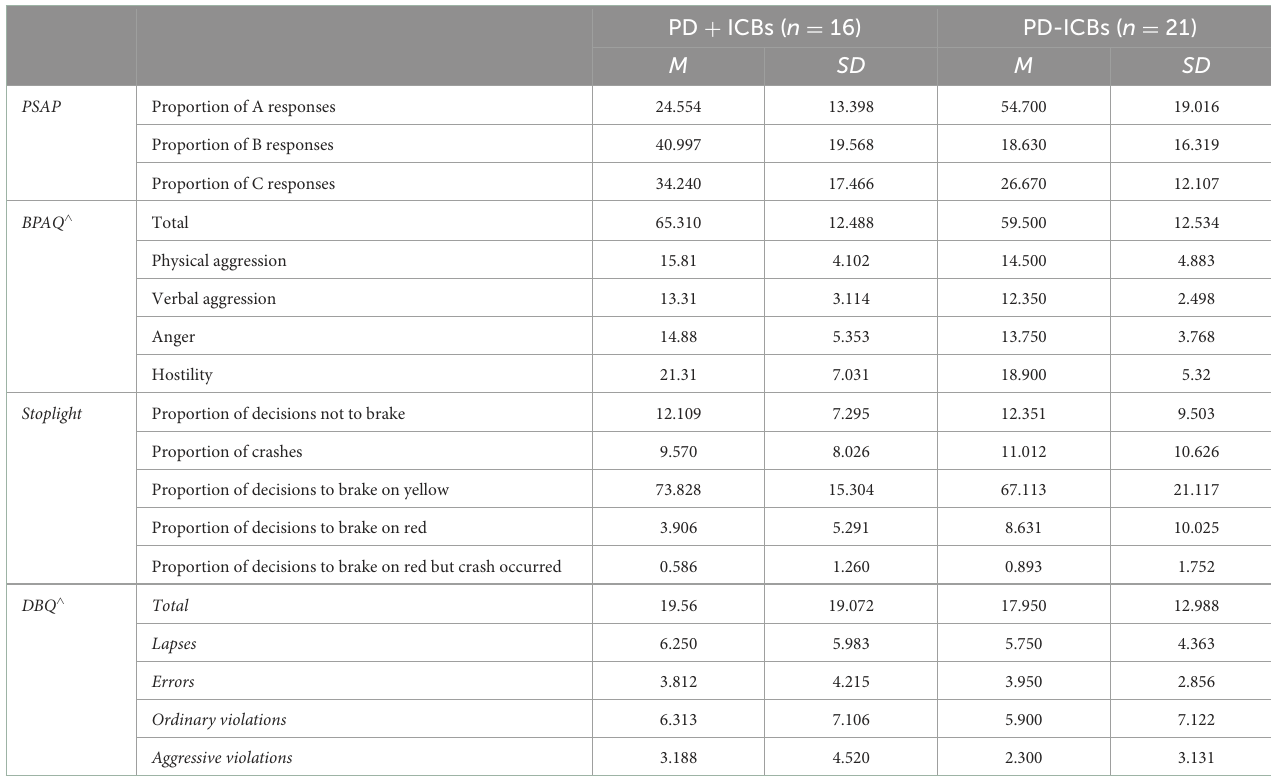
TABLE 4 Groups’ performance on antisociality